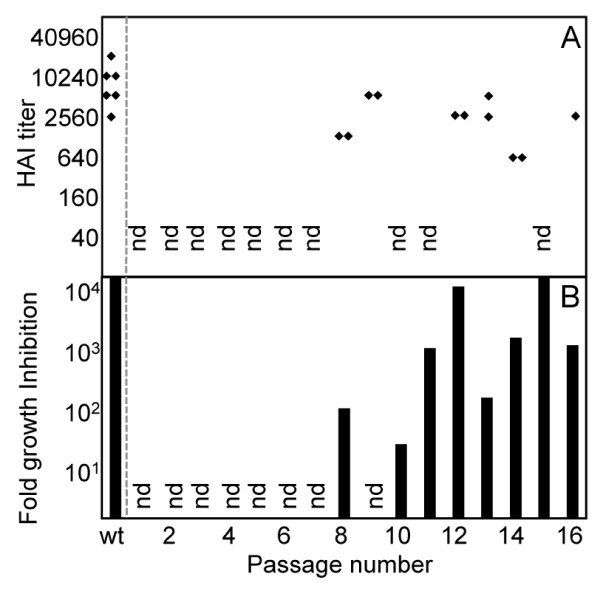
Successful growth in the presence of IgY does not correlate with lack of susceptibility to neutralization. Selected passages were tested for sensitivity to hemagglutination inhibition (HAI) by immune IgY (A), and neutralization of infection compared to infection in the absence of IgY (B). Note that the y-axis in panel B is logarithmic (nd: no data available).